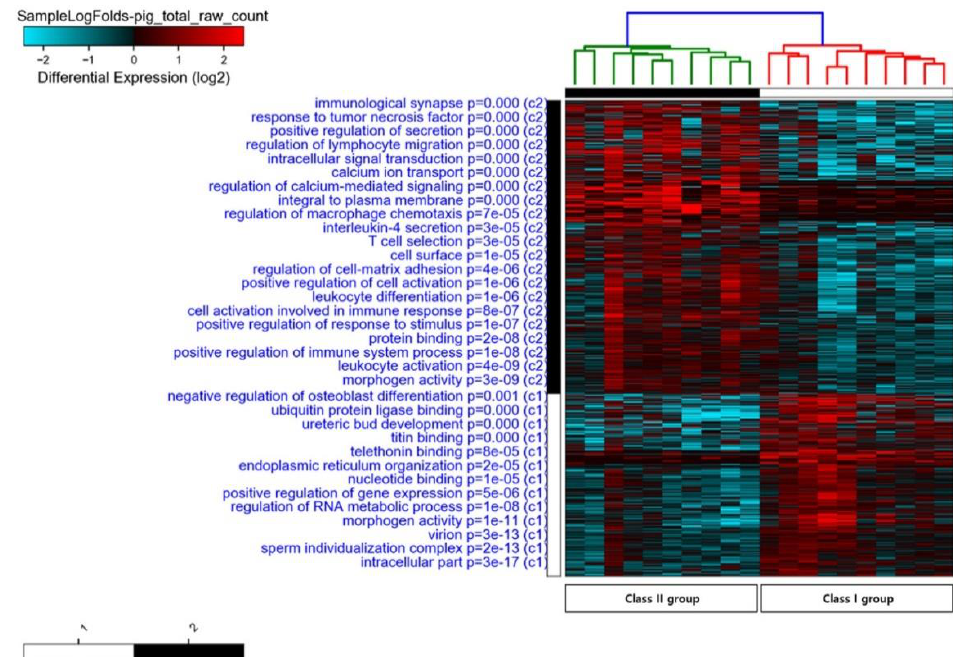
4 of 9 Figure 1. Plot of principal component analysis. Relative abundance log folds accounting for the total raw count are shown. Red point: class I (first plus grade), blue point: class II (second grade). 3.2.. Putative Candidate Genes Involved in Loin Muscle Carcass Quality To identify the putative biological function of the DEGs, GO function and KEGG pathway enrichment analysis were performed for the libraries from class I and class II by assigning GO terms associated with the unigenes. Significantly, 2757 gene sets were enriched (FDR < 25%) in class I and